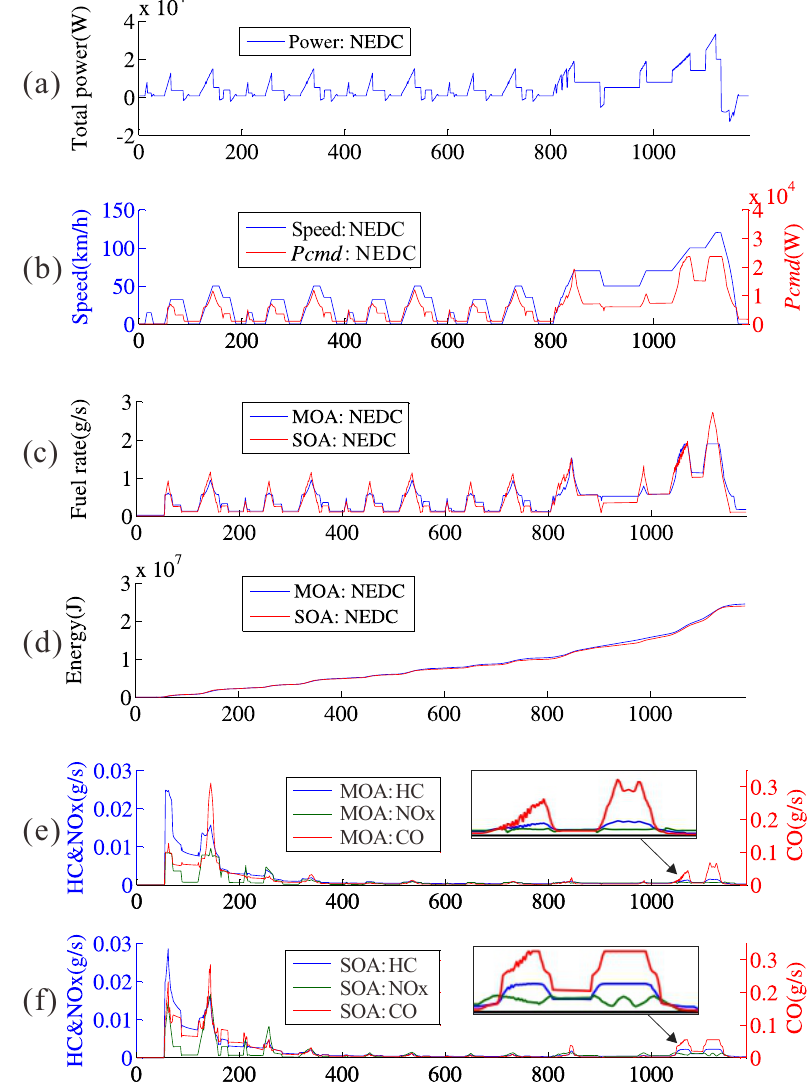
Figure 9. Required total power, speed, power, fuel rate, cumulative energy consumption and emissions of the New European driving cycle (NEDC) driving cycle. ( a ) total power; ( b ) speed and power; ( c ) fuel rate; ( d ) cumulative energy consumption; ( e ) emissions from MOA; and ( f ) emissions from single-objective approach